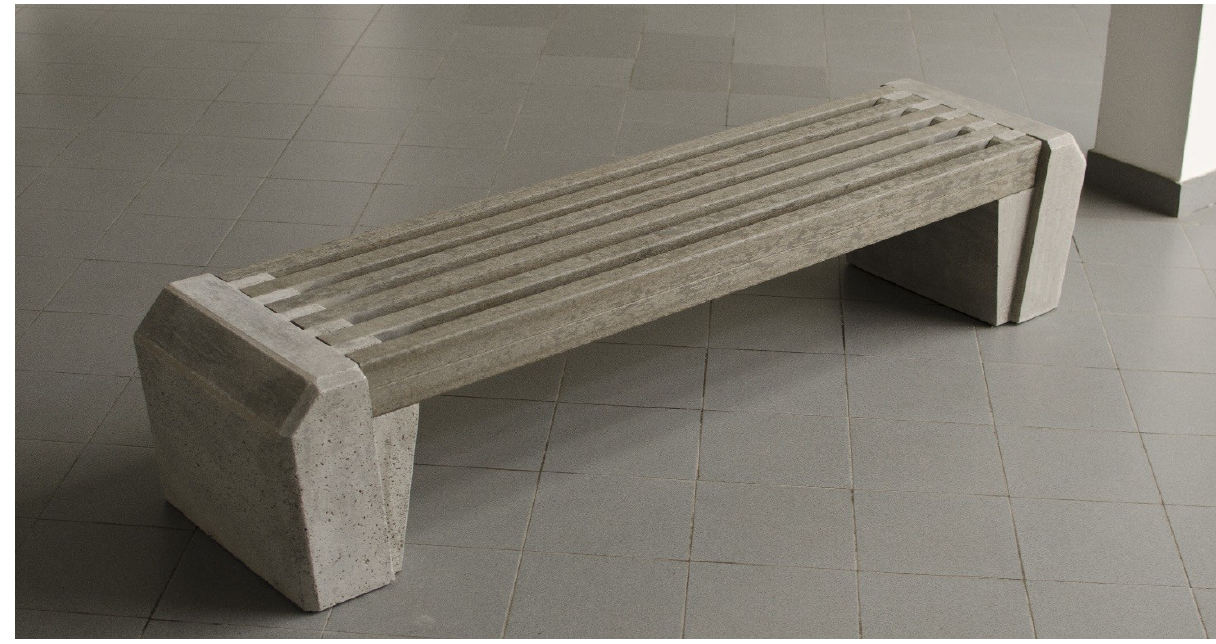
Figure 14. Picture of the bench produced with Prowaste